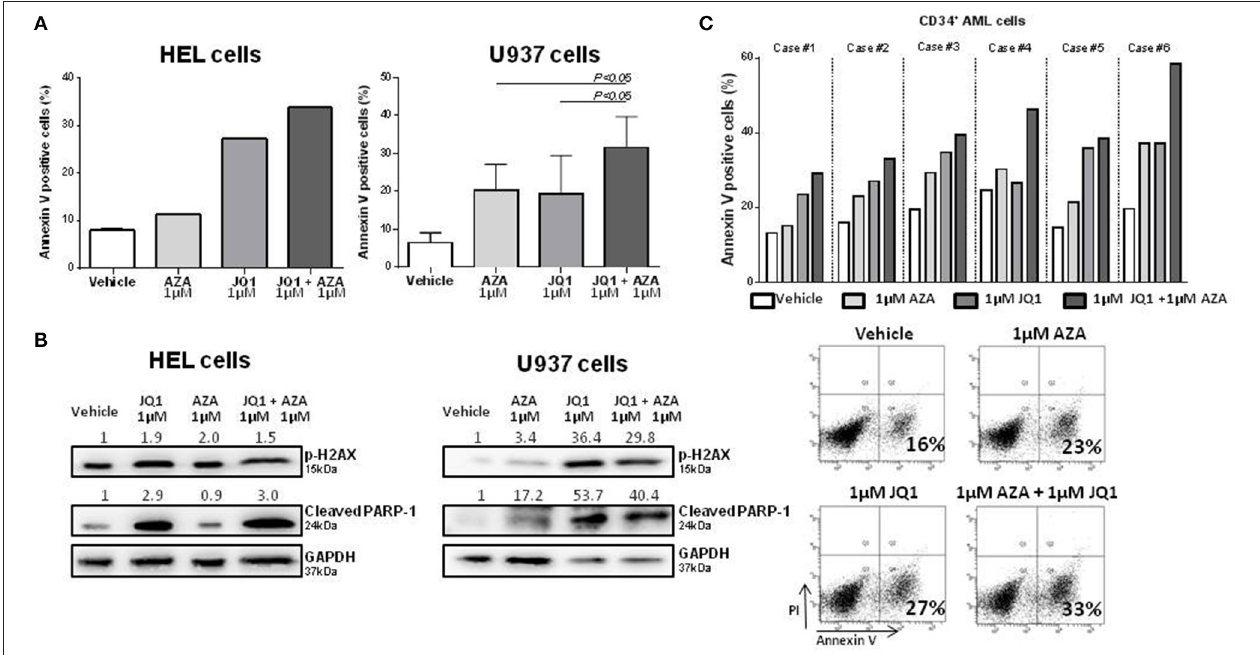
FIGURE 3 | Combined treatment of JQ1 and azacitidine induces an additive effect on apoptosis of HEL, U937, and primary AML cells. (A) Apoptosis rate of HEL and U937 cell lines treated with JQ1, AZA, or JQ1 + AZA for 48 h: Bar graphs show mean ± SD of at least four independent experiments. (B) Western blotting of HEL and U937 cell lines extract showing increased p-H2AX and cleaved PARP expression after JQ1 + AZA treatment. Densitometry was performed and the ratio of target proteins vs. GAPDH compared with the normalized value of control is shown. (C) Apoptosis rate of 5 primary CD34 + AML cells treated with JQ1, AZA, and JQ1 + AZA and a representative plot showing increasing apoptosis under JQ1 + AZA